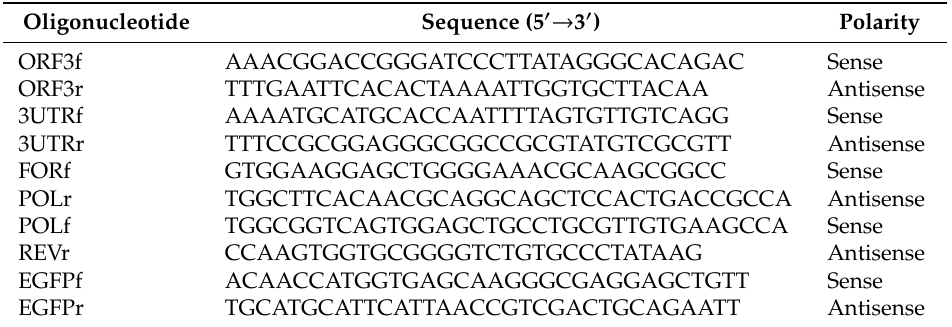
Table 1. Oligonucleotide primers used for the construction of reporter-encoding full-length ZIKV cDNA